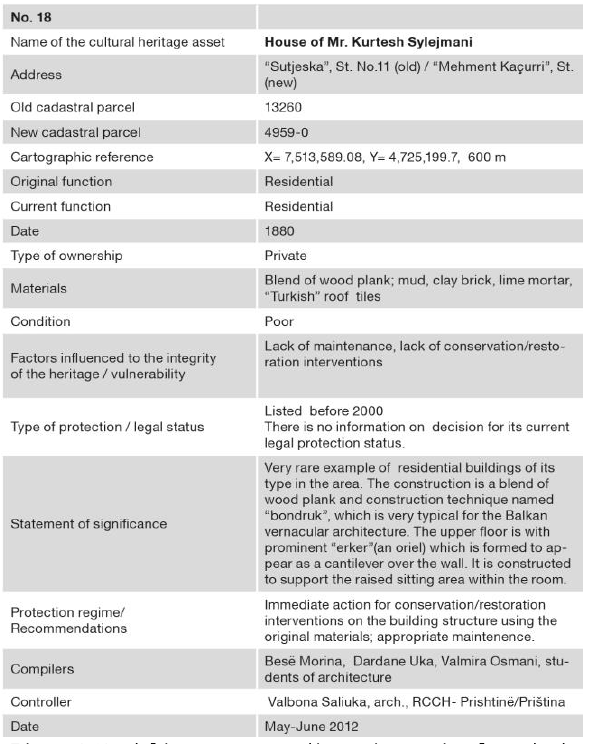
Figure 4. Model inventory according to international